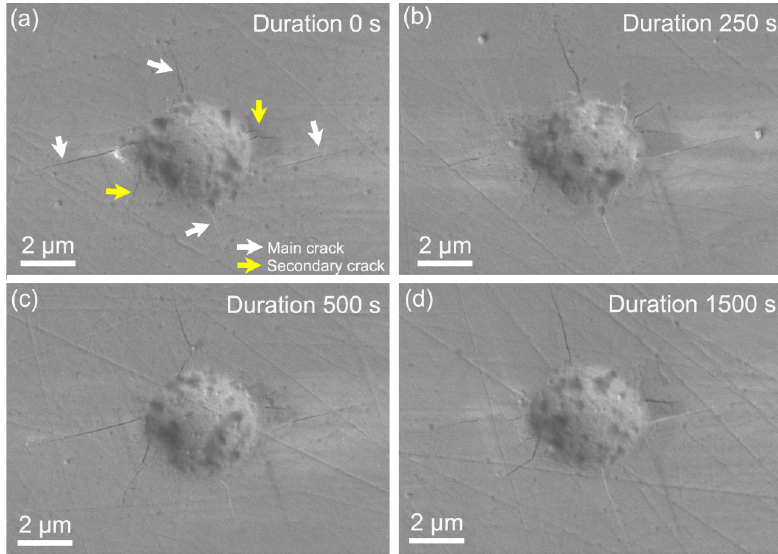
Figure 5. The surface morphologies of residual nanoindentation impressions by SEM observation on the samples at the holding stages of ( a ) 0 s, ( b ) 250 s, ( c ) 500 s and ( d ) 1500 s. From the SEM images, it could be seen that symmetric cracks of several micrometers in length appeared along four directions with an angle of 90 degrees, as indicated by white arrows in Figure 5a. Here, we defined these primary cracks as the main crack. According to the slip system perpendicular to X-112° in Figure 1b, the ( 1(cid:3364) 120) and (0001) might be the slip planes during nanoindentation deformation. Besides, several tiny cracks could also be observed, of which orientations were disordered as indicated by yellow arrows. The four main cracks appeared in all the residual impressions, thus its total count was constant. As exhibited in Figure 6a, the total count of secondary cracks in sixteen tests was dramatically increased from 27 to 40 after 250 s holding, and then secondary cracks were slowly increased from 40 to 47 by increasing holding time to 1500 s. Figure 6b shows the mean lengths of main and secondary cracks, which were both increased about 100 nm after 250 s holding and nearly invariable by further increasing holding time. In addition, mean lengths of the main cracks along four orientations were summarized in Figure 7. All the main cracks followed a similar variation trend with increasing holding time as shown in Figure 6b, which further illustrated a uniform extension of cracks during holding stages. According to statistical results in Figure 6, the main mechanisms of time-dependent plastic deformation in LiTaO 3 on the three holding stages could be qualitatively unfolded, relying on the length evolution of pre-existing main cracks and generation of new secondary cracks.